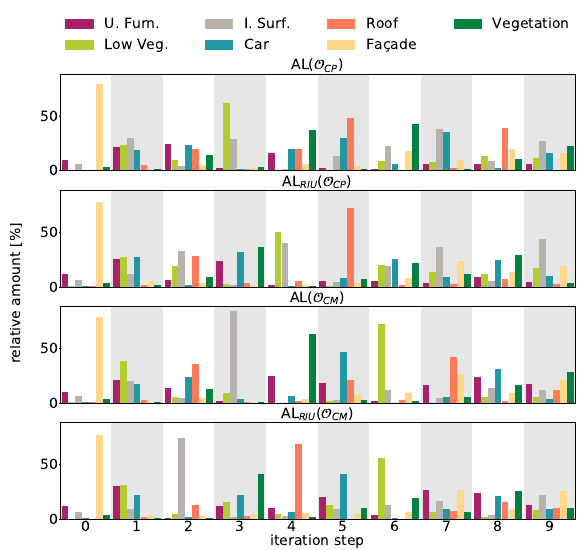
Figure 5. Histograms of true class affiliation of selected most informative points in each iteration step.